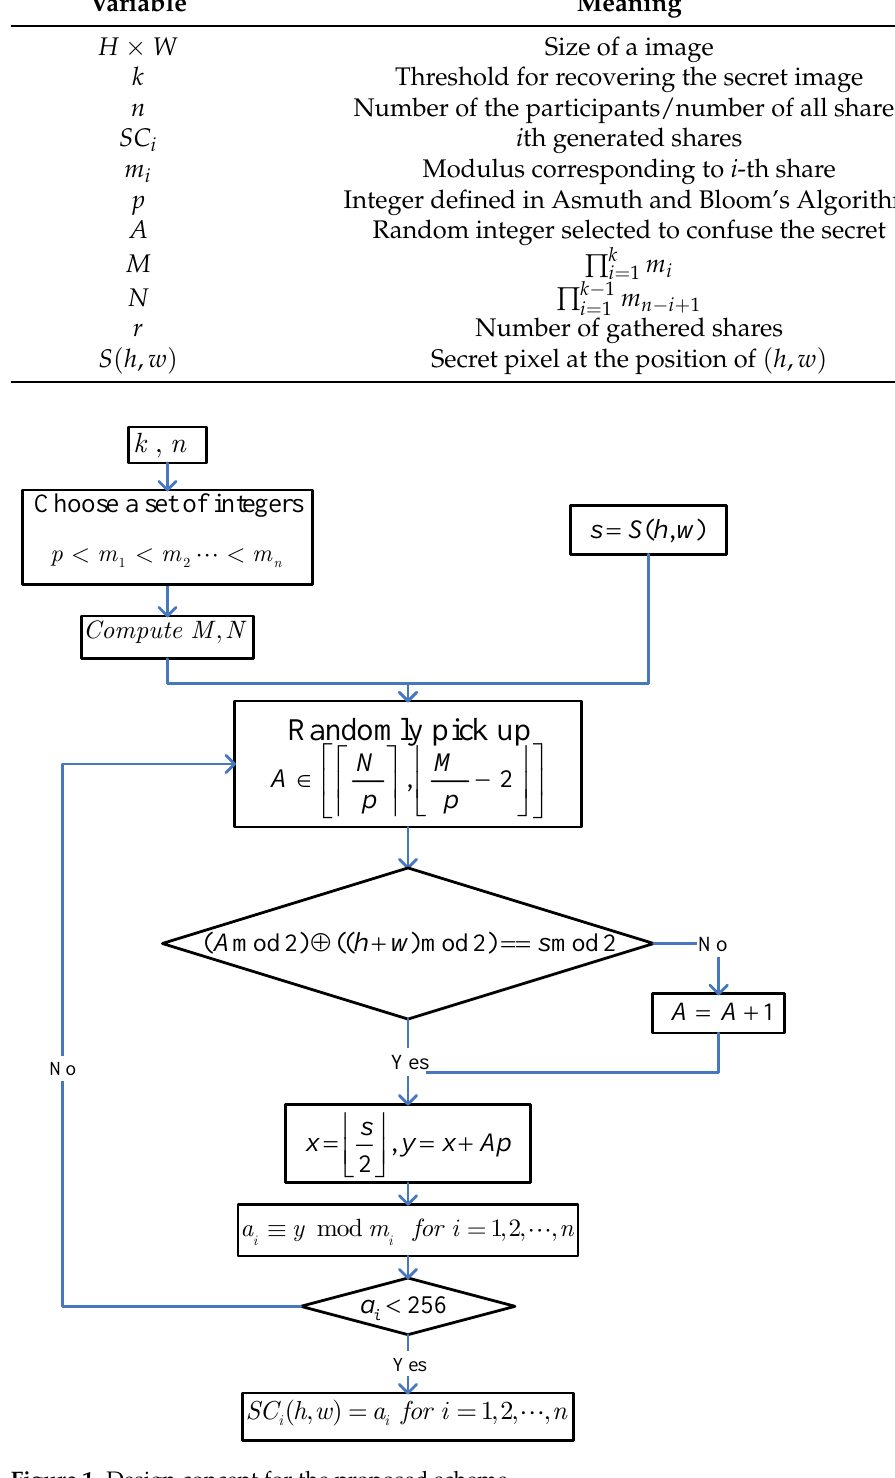
Figure 1. Design concept for the proposed